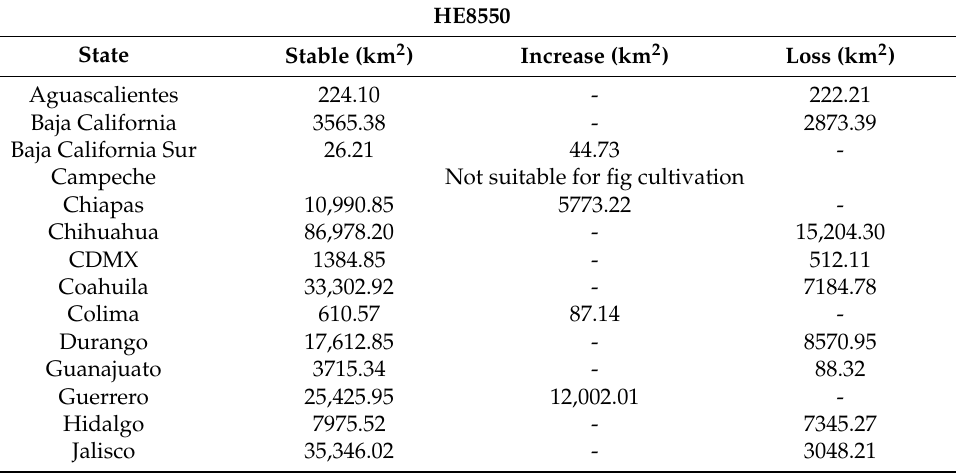
Table A2. Area estimated of fig crop for the year 2050 for the HADGEM2-ES Model with RCP